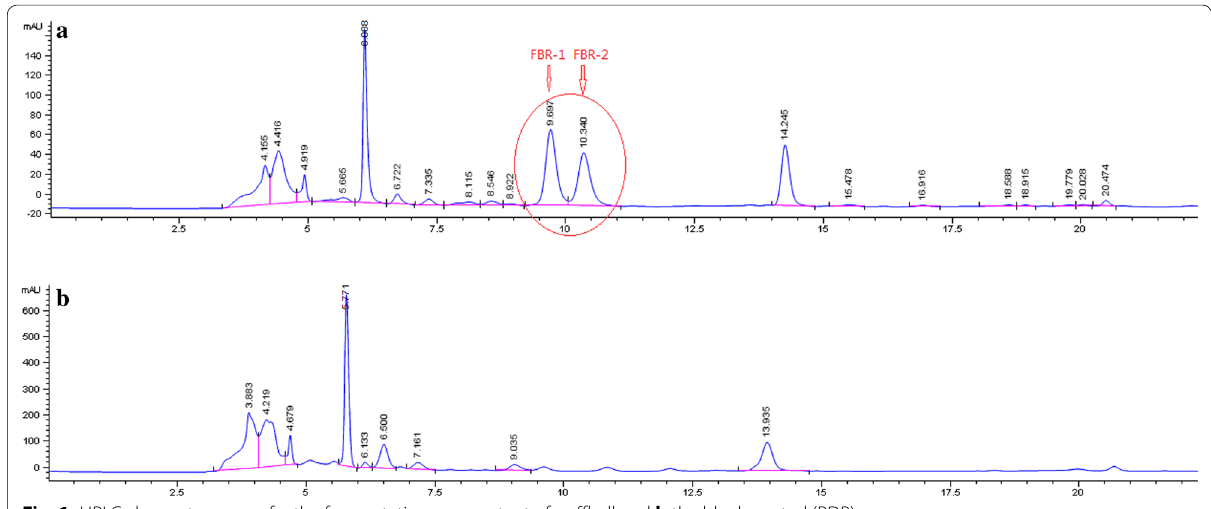
Fig. 1 HPLC chromatograms of a the fermentation supernatant of puffball and b the blank control